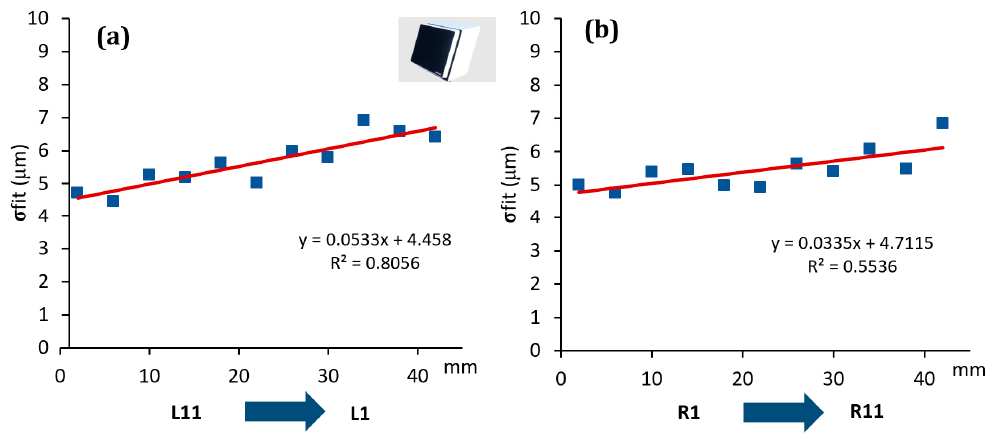
Figure 9. Trend of the sigma fitting error ( σ fit) evaluated considering the distance from the sensor/light source for LLS scanner. Left groove sides ( a ) and right groove sides ( b ).